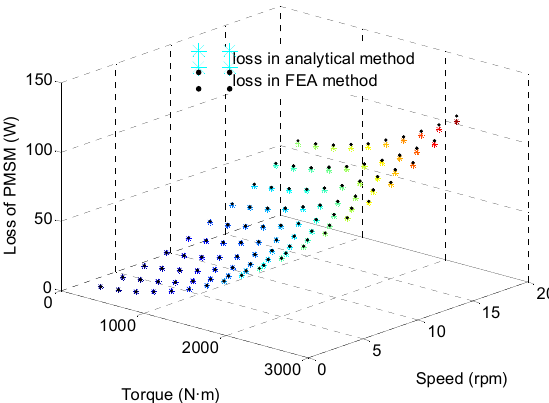
Figure 3. Simulation model of the FEA.